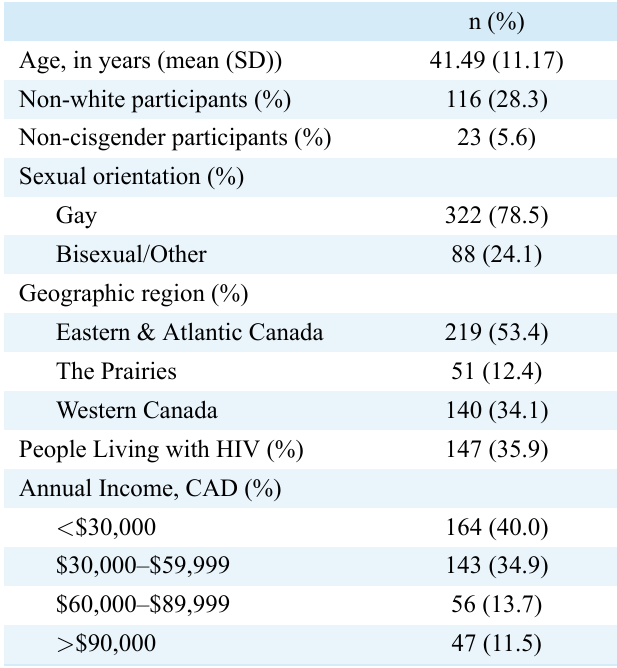
TABLE 1. Demographic characteristics of sexual minority men and non-binary people in Canada who use crystal methamphetamine (N =